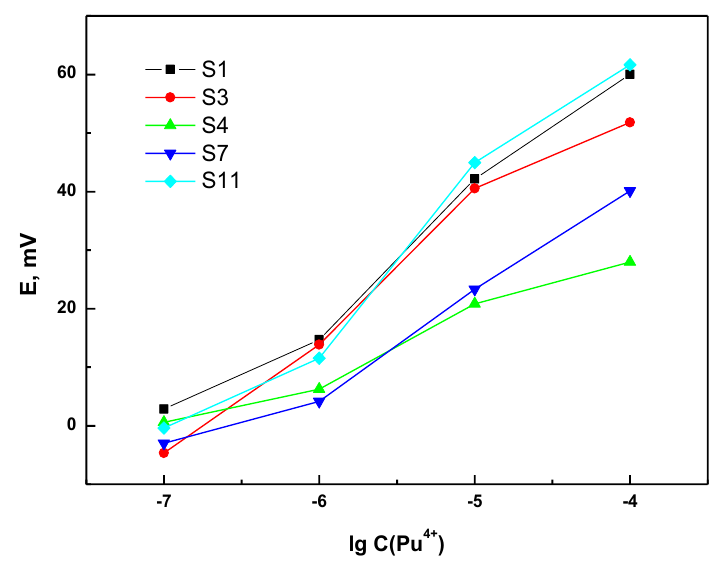
Figure 1. Typical potentiometric response curves in Pu 4 + aqueous solutions with 1.5 M HNO 3 . The presented EMF values are determined with ± 0.1 mV precision.